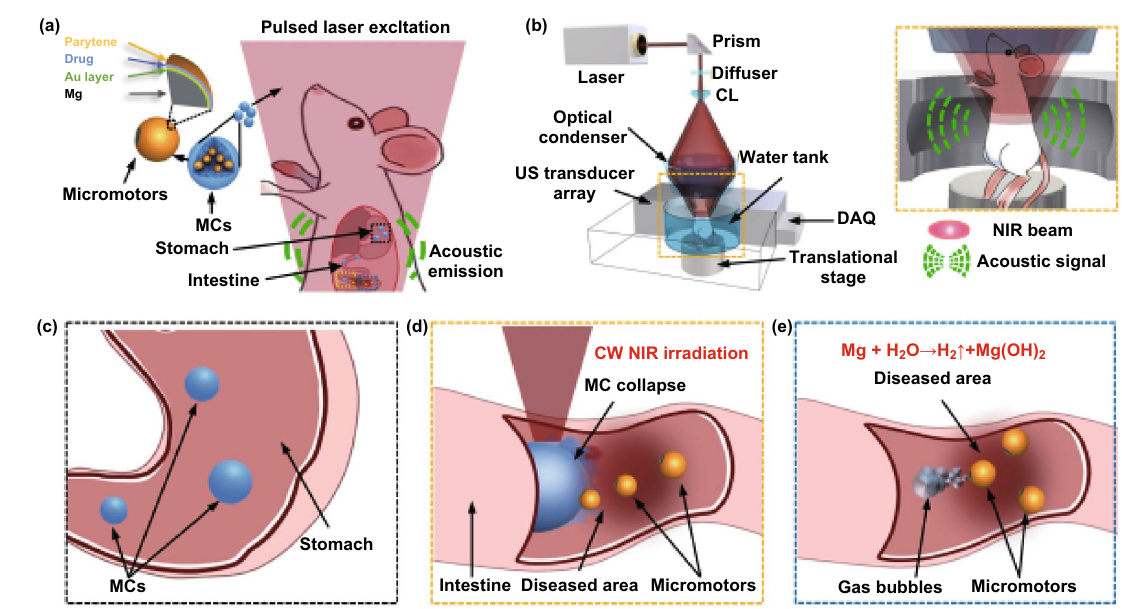
Fig. 4 Schematic of PAMR in vivo. a Schematic of the PAMR in the GI tract. The MCs are administered into the mouse. NIR illumination facilitates the real-time PA imaging of the MCs and subsequently triggers the propulsion of the micromotors in targeted areas of the GI tract. b Schematic of PACT of the MCs in the GI tract in vivo. The mouse was kept in the water tank surrounded by an elevationally focused ultrasound transducer array. NIR side illumination onto the mouse generated PA signals, which were subsequently received by the transducer array. (Inset) Enlarged view of the yellow-dashed box region, illustrating the confocal design of light delivery and PA detection. US, ultrasound; CL, coni- cal lens; DAQ, data acquisition system. c Enteric coating prevents the decomposition of MCs in the stomach. d External CW NIR irradiation induced the phase transition and subsequent collapse of the MCs on demand in the targeted areas and activated the movement of the micromo- tors upon unwrapping from the capsule. e Active propulsion of the micromotors promoted retention and cargo delivery efficiency in intestines. Adapted from Ref. [67] with permission, copyright American Association for the Advancement of Science,